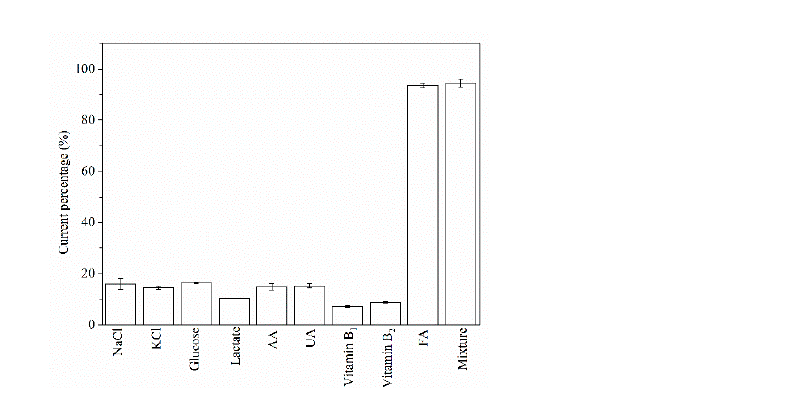
Figure 5. I FA measured from SWV curves of ZIF-67/AgNWs@SPCE in the presence of FA (1 μ M) and 0.1 mM of each interfering substance. Current percentage (%) = (I 0 − I)/I 0 × 100%, where I 0 represents the I FA detected without the addition of FA (control), and I was measured with addition of FA (1 μ M) or each interfering substance (0.1 mM). Mixture indicates all interfering substance and FA. All measurements were repeated six times.